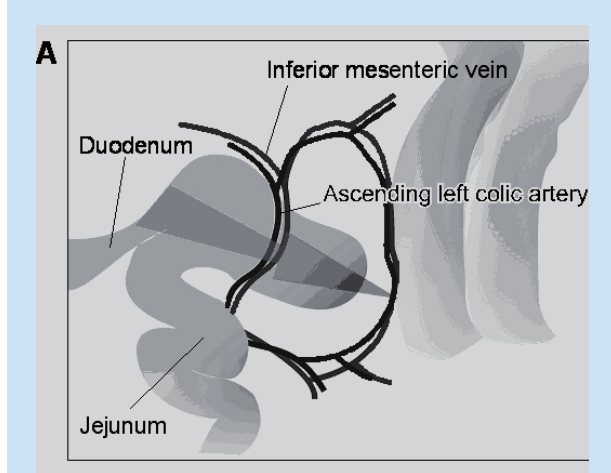
Fig. 4a. Schematic illustration demonstrating a left paraduodenal hernia behind the ascending left colic artery into the fossa of Landzert.